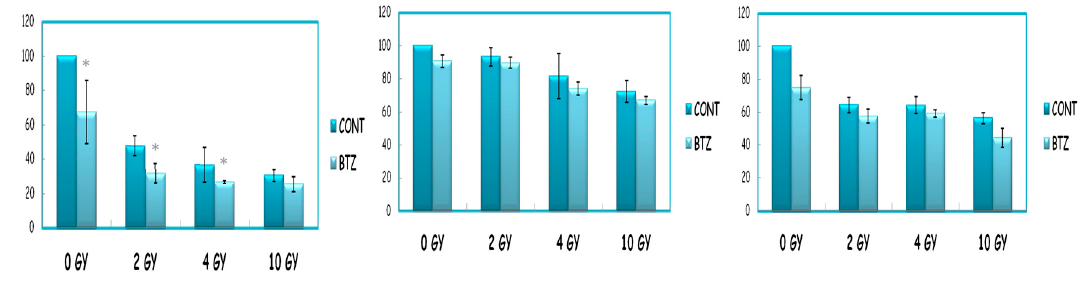
Figure 1. Percentage of 2D culture GBM cell viability treated with different doses of radiotherapy ( a ) 24 h, ( b ) 48 h and ( c ) 72 h. * p < 0.05 versus controls.